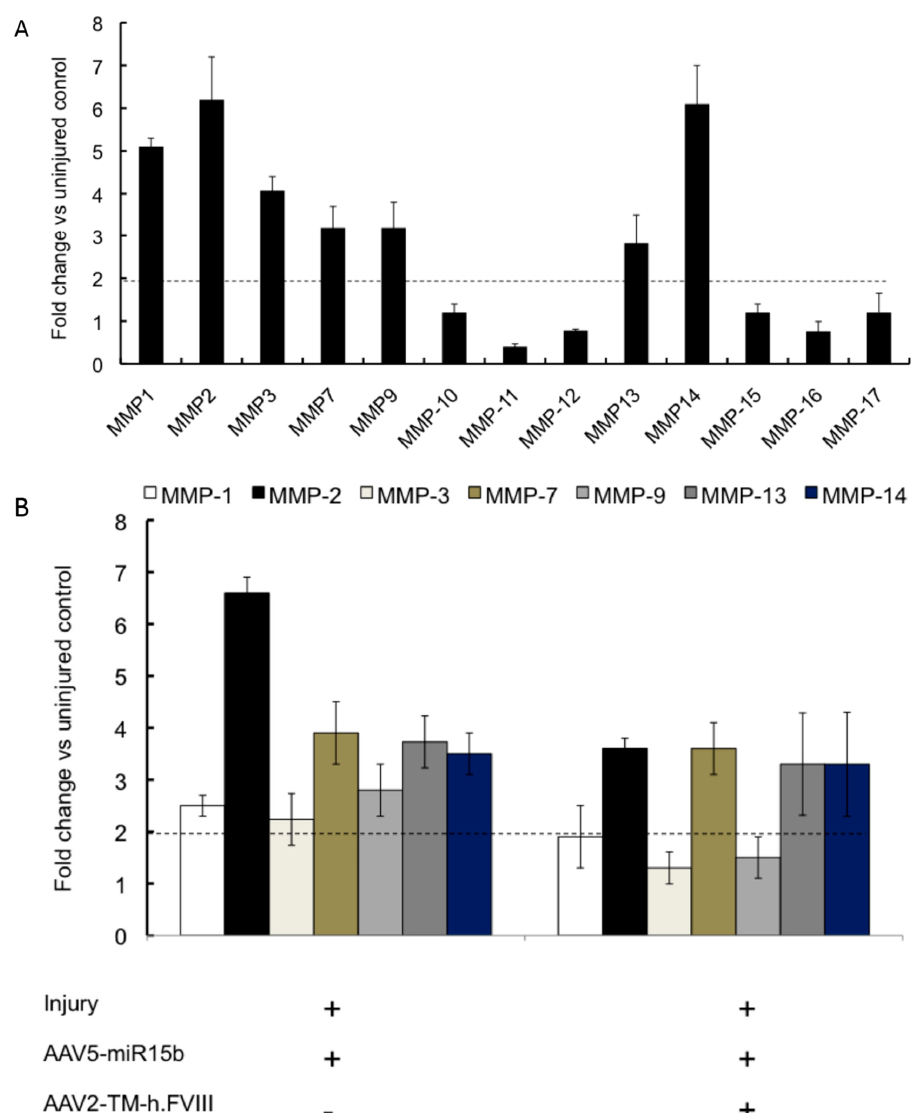
Figure 6. Profile of matrix metalloproteinase (MMP) in joints and the effect of AAV-miR15b/FVIII delivery in multiple injury model. ( A ) Expression levels of the various MMPs following four episodic bleeds when compared to the uninjured control; ( B ) Modulation of MMPs 1, 2, 3, 7, 9, 13, and 14, which were found to be significantly elevated in (A), by administration of AAV5-miR-15b and/or AAV2-TM-h.FVIII vectors. The horizontal dotted line denotes statistical level of significance in comparison to uninjured control joints.